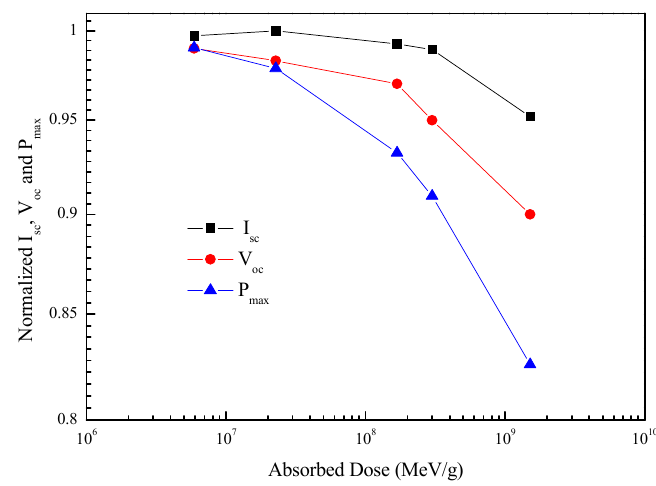
Figure 2. Normalized short-circuit current (I sc ), open-circuit voltage (V oc ), and the maximum power (P max ) in the InGaP/GaAs/Ge triple-junction (3J) solar cells as a function of the absorbed dose. The degradation rates of the I sc , V oc , and P max increased with an increase in absorbed dose. The